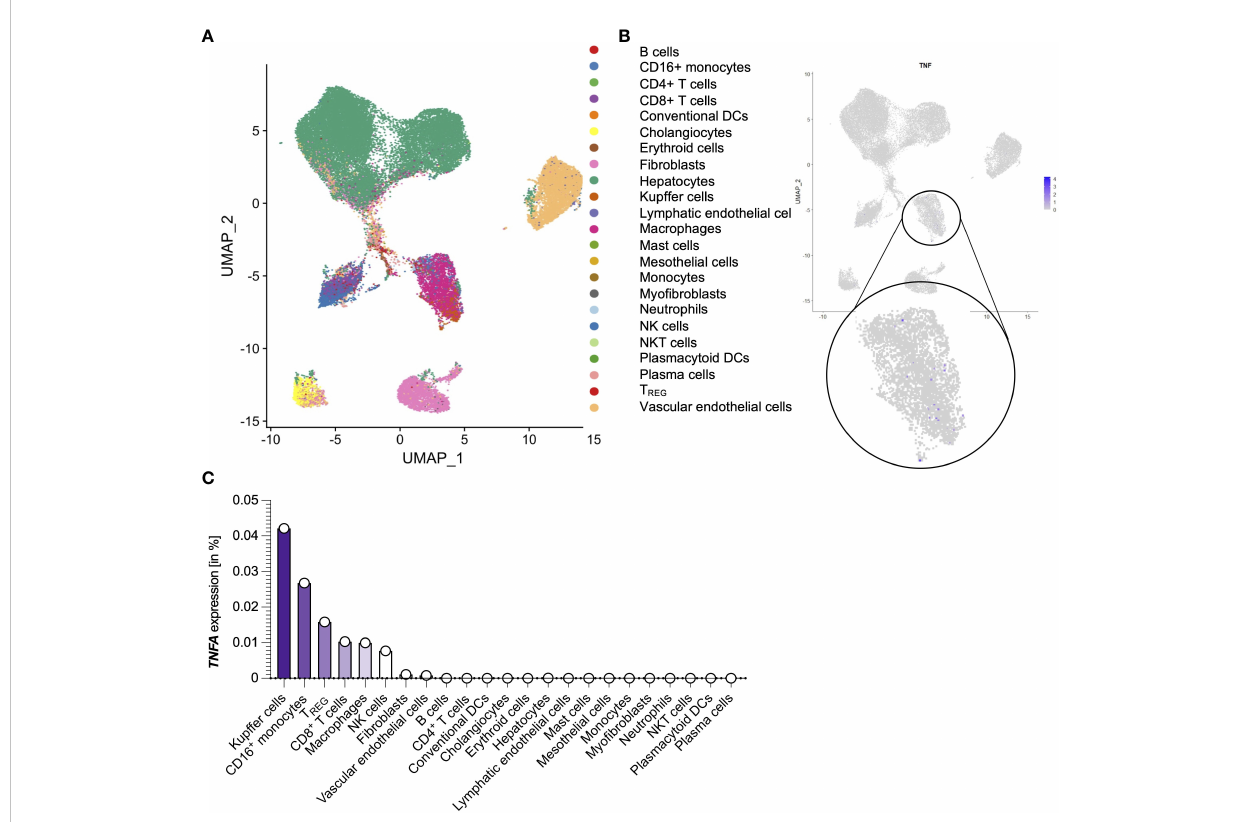
FIGURE 2 Liver-derived TNFA is predominantly produced by Kupffer cells and monocytes during SARS-CoV-2 infection. (A) Cell clusters from the livers of 15 SARS-CoV-2 infected patients that were identi fi ed using single-cell sequencing of a publicly available dataset (35). (B) TNFA expression of the cell clusters as described in (A) . (C) Percentage of TNFA -expressing cells divided by clusters as described in (A) . ns, not signi fi